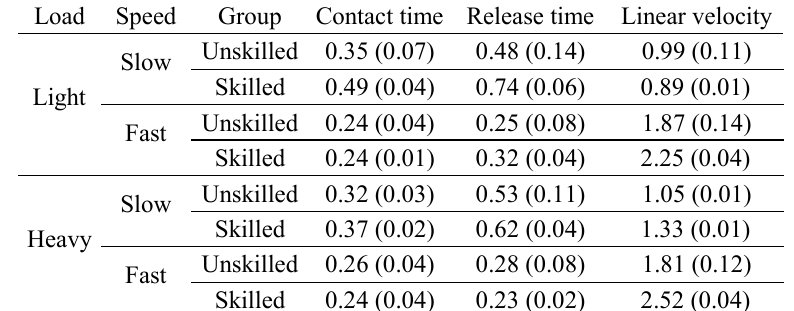
Table 1. Mean values of the time and the speed parameters during the propulsion cycle Load Speed Group Contact time Release time Linear velocity